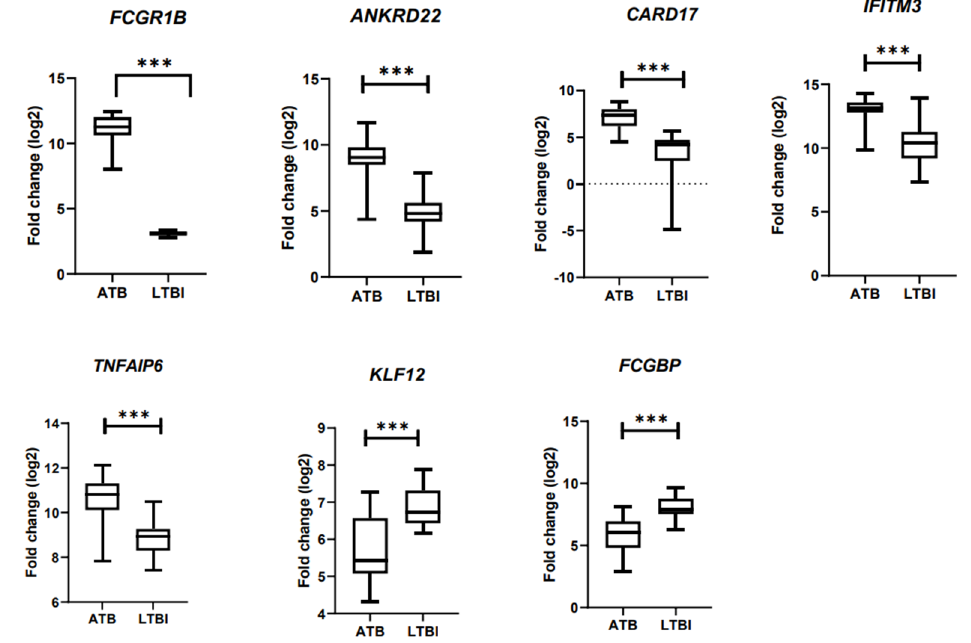
Figure 3. Validation of DEG in an independent cohort using bioinformatics analysis. *** p < 0.001.